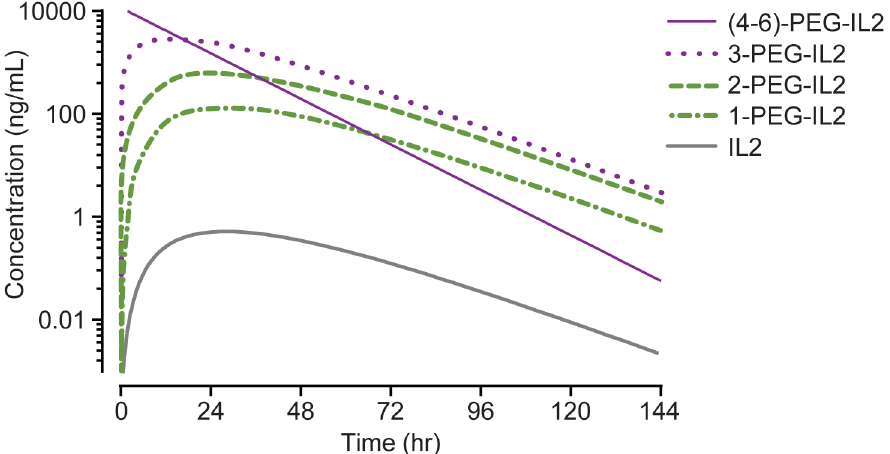
214. A key goal for developing the mechanistic model was to understand the receptor bias towards the IL2R βγ over IL2R αβγ in greater detail. The IL2R βγ complex is predominantly expressed on CD8 T cells and on NK cells; whereas, IL2R αβγ is constitutively expressed on